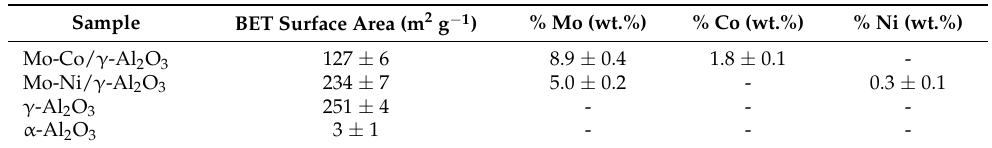
Table 1. Metallic content of the catalysts, determined by ICP-OES analysis and surfaces areas of the materials (BET